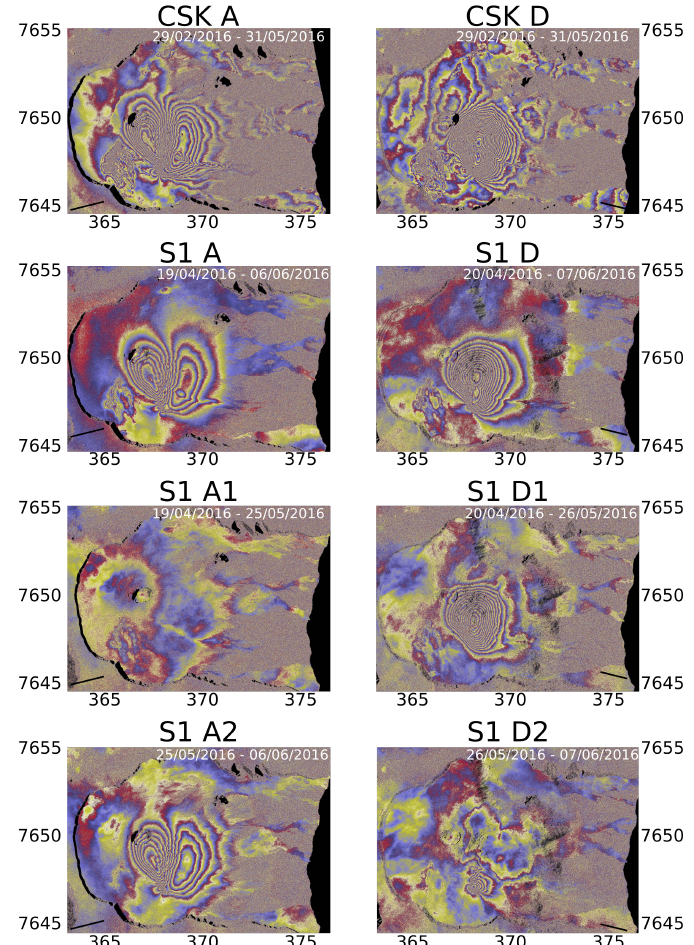
Figure 3. Wrapped interferograms used in this study. ( Left column ) Data acquired on ascending orbits; ( Right column ) Data acquired on descending orbits; ( First row ) Cosmo-Skymed data (X-band) spanning the whole eruptive period; ( Second to Fourth rows ) Sentinel-1 InSAR ascending and descending data (C-band); ( Second row ) Sentinel-1 data spanning the whole eruptive period; ( Third row ) Sentinel-1 data spanning the first time period; ( Fourth row ) Sentinel-1 data spanning the second time period; For Cosmo-Skymed data, fringes represent 1.5 cm LOS displacement,